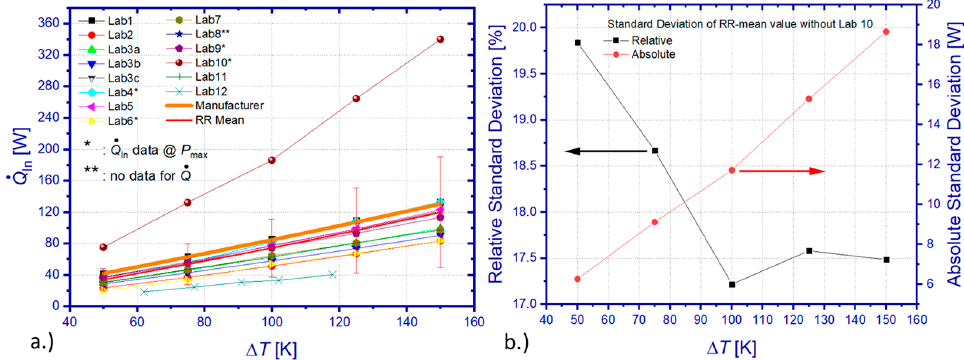
Figure 10. RR results for incident heat flow Q In at conditions of maximum efficiency operation in dependence on the temperature difference Δ T ( a ). The temperature-dependent mean value (RR mean) and the standard deviation have been calculated from all data sets for the left diagram. The standard deviation is indicated here by error bars for the RR mean. This diagram contains additionally a comparison to manufacturer specifications. The absolute and relative standard deviations have been calculated, excluding data from Lab 10 ( b ).